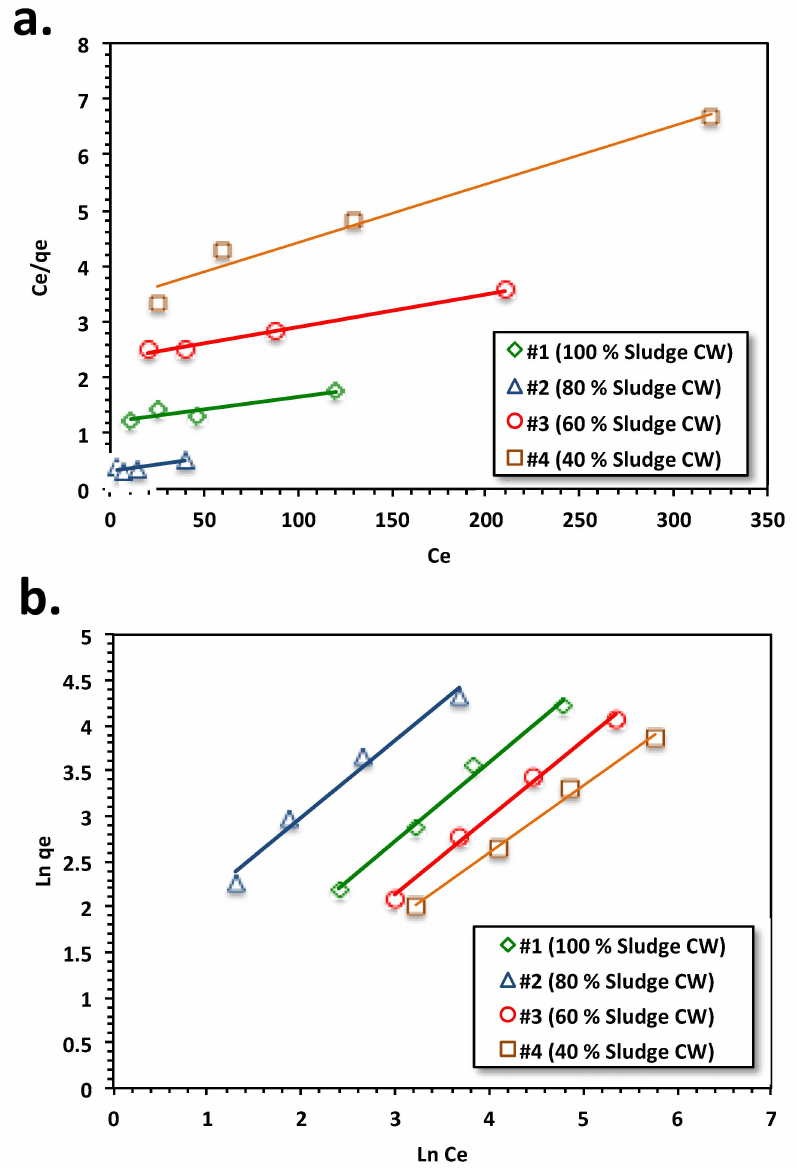
Figure 9. Comparison of ( a ) Langmuir and ( b ) Freundlich isotherm models of Flytek removal on alum sludge